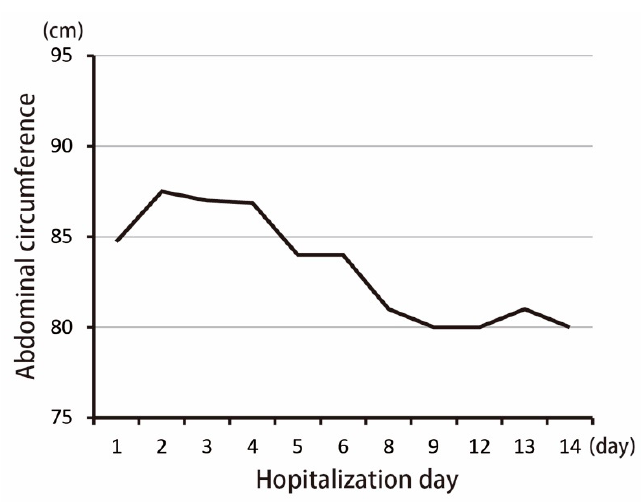
Figure 3. Change in abdominal circumference after hospitalization.